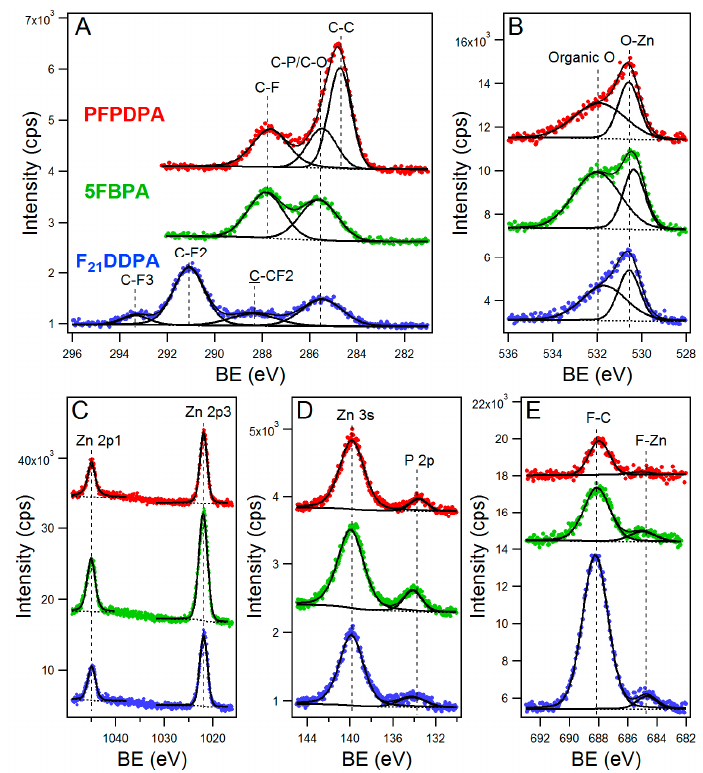
Figure 3. High-resolution X-ray photoelectron spectroscopy (XPS) spectra and fits ( A ) C1s ( B ) O1s ( C ) Zn2p ( D ) P2p, and ( E ) F1s core level spectra of PFPDPA on ZnO (red lines), 5FBPA on ZnO (green lines), and F21DDPA on ZnO nanoparticles (blue lines). Curves are shifted along the Y-axis to enable better comparison.